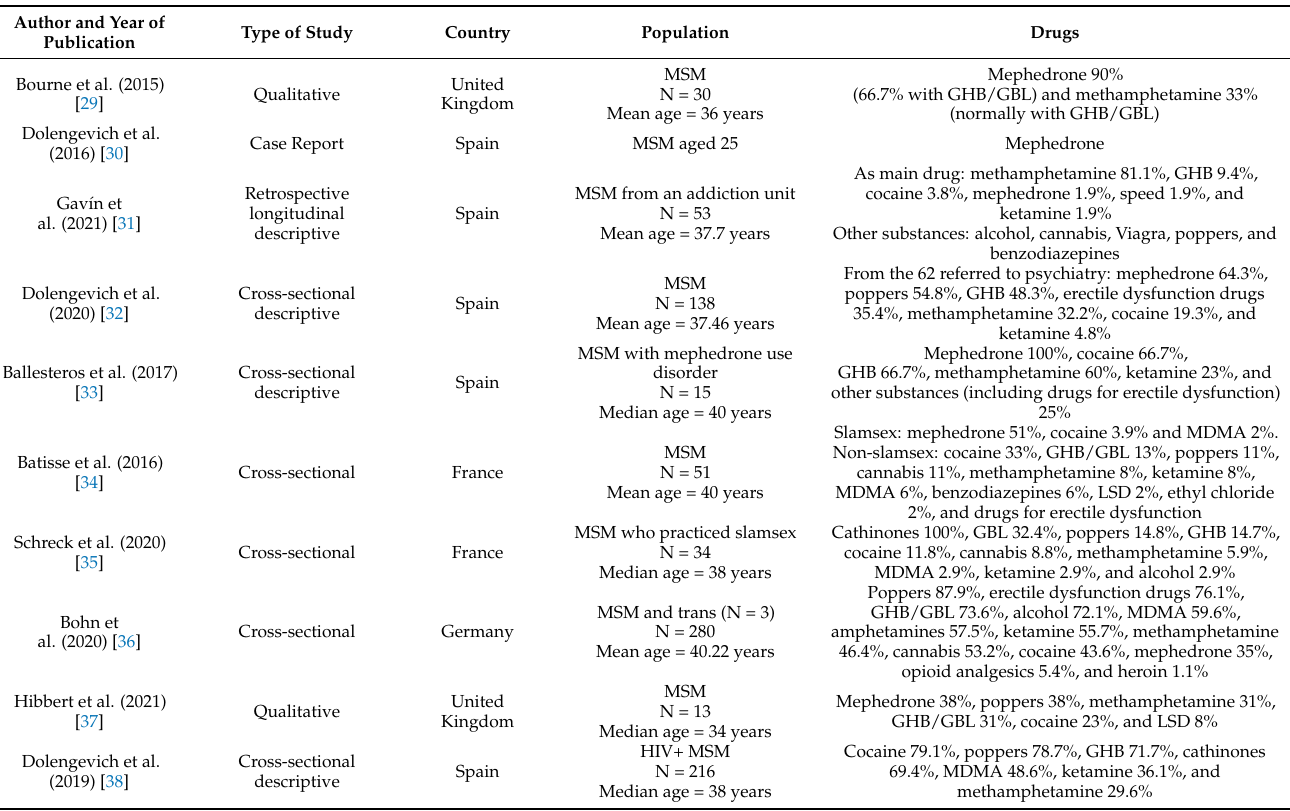
Table 2. Studies selected characteristics